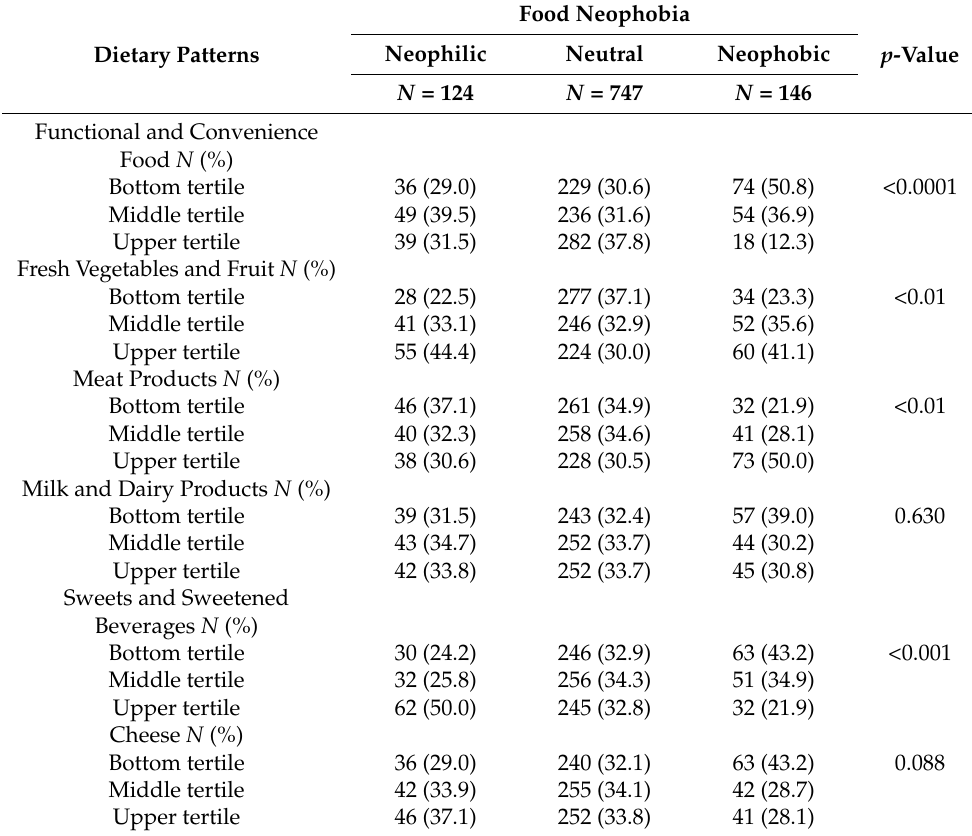
Table 4. Associations between the level of food neophobia and dietary patterns in the total sample ( N =